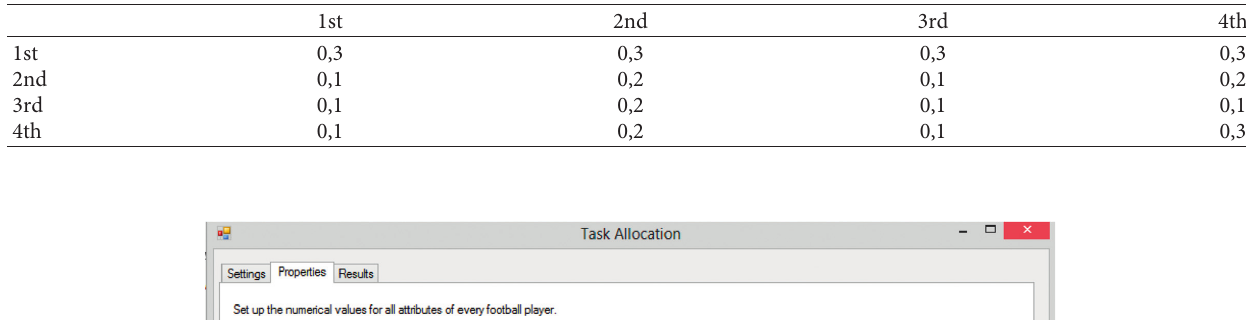
Figure 9: Entering the values of the robotic properties of the group of red and blue in the first experience. Table 2: Solving the goal assignment problem in the first experiment.